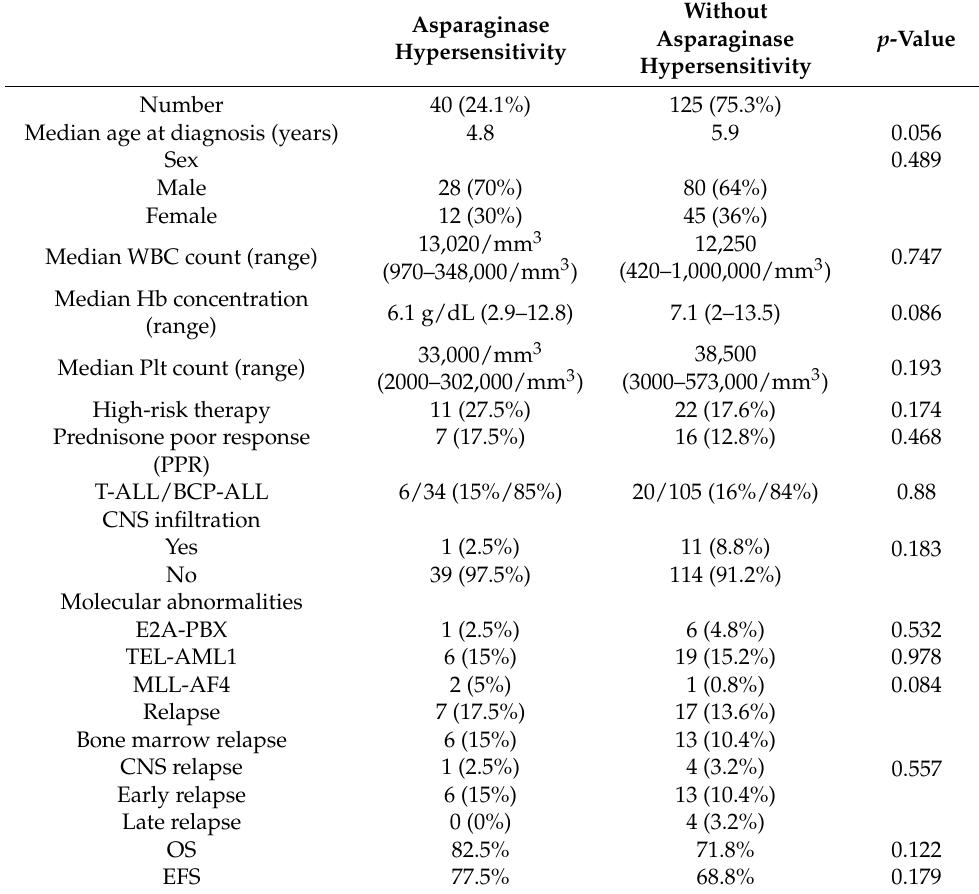
Table 3. Biological features and outcomes of patients with and without L-asparaginase clinical